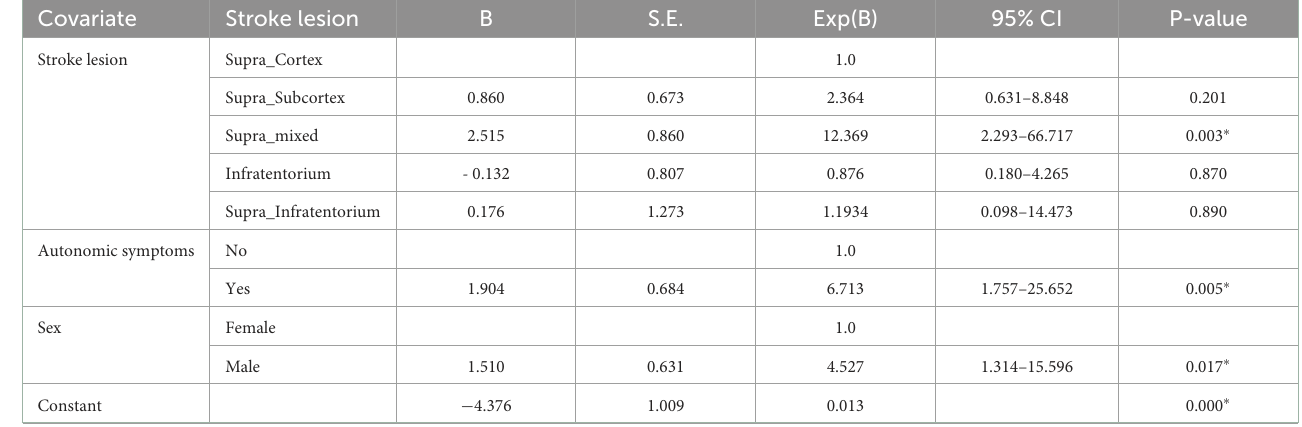
TABLE 3 Risk factors for chronic rhinitis.